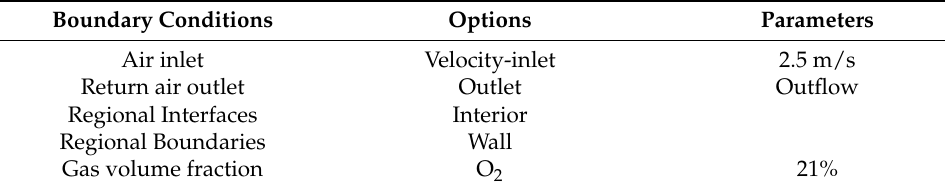
Table 2. Physical model parameters of the extraction area.